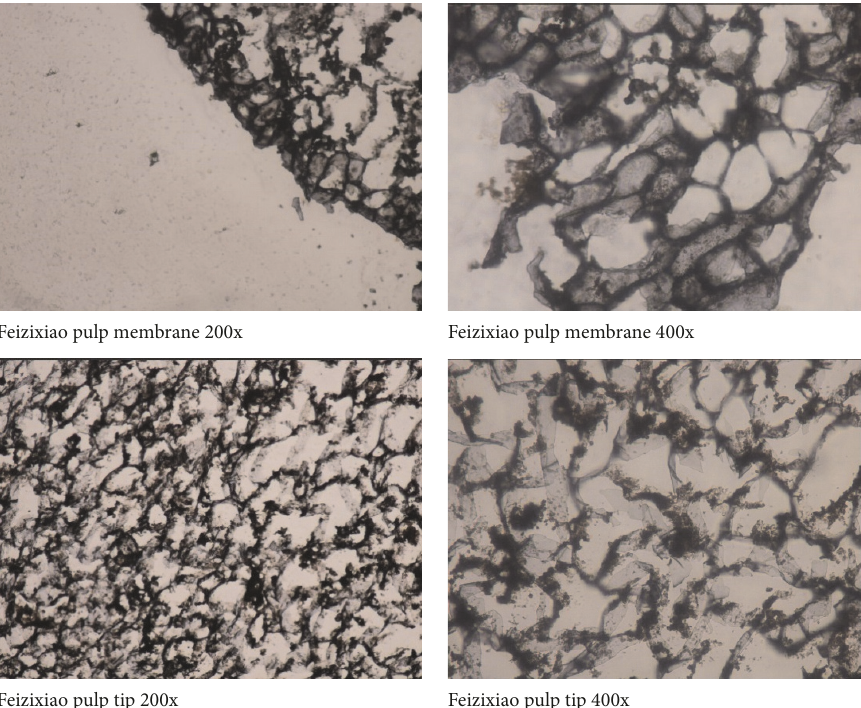
Figure 5: The light micrographs for Feizixiao lychee pulp membrane and tip.